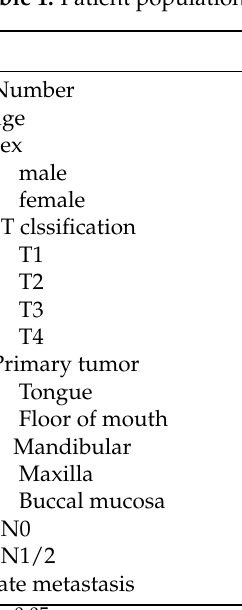
Table 1. Patient